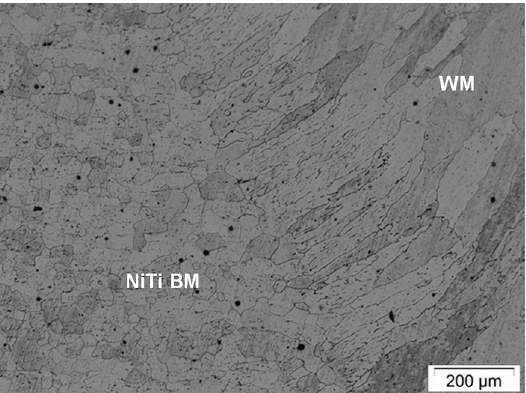
Figure 7. S12 joint microstructure observed through OM, interface between BM and